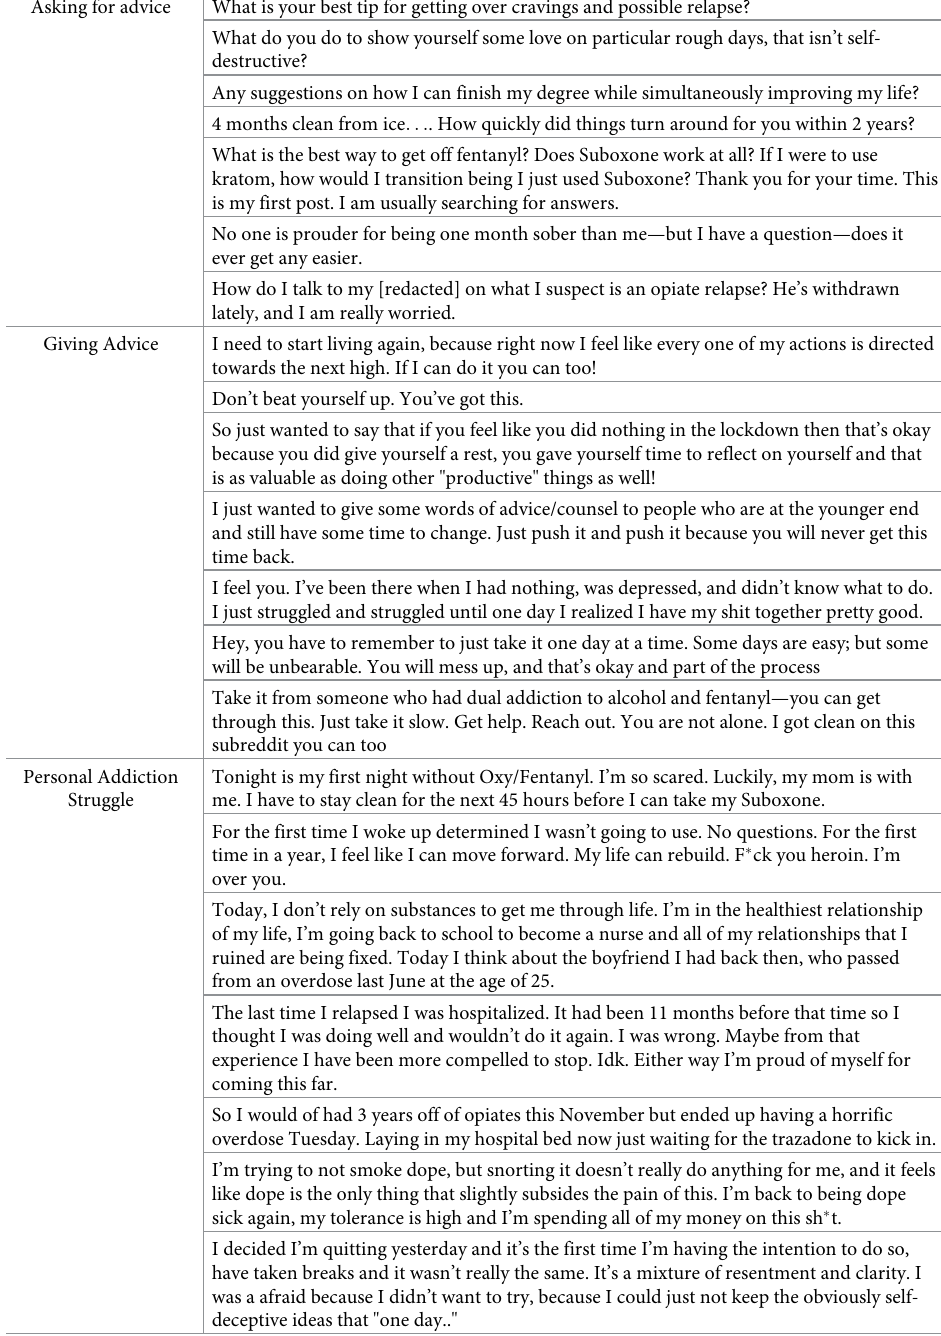
Table 1. Example abridged and anonymized Reddit posts pulled from each centroid outlined in the PCA vector map. Asking for